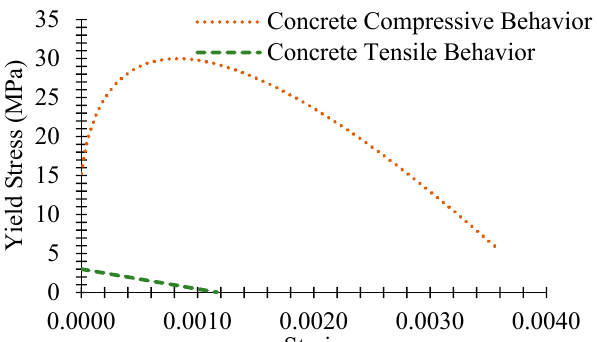
Figure 3. Input of stress–strain variation for M30 grade of concrete liner used in tunnel.